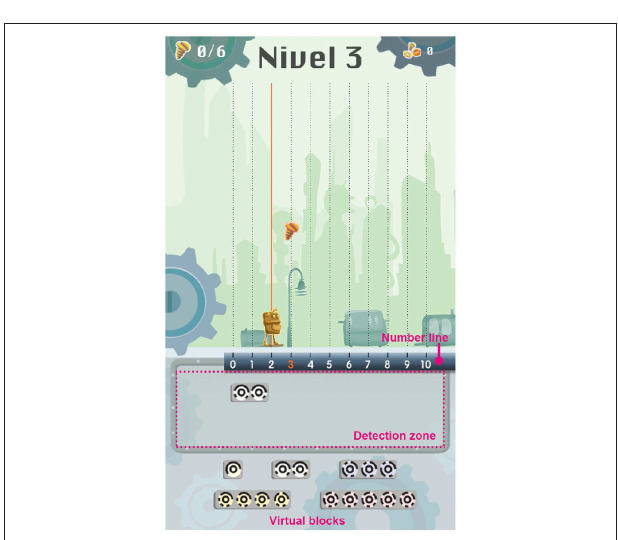
FIGURE 2 | Fully virtual version of BrUNO. Prize placed in number three (as indicated by the orange color). The player has already introduced 1 block of value 2. To reach the prize, he must add one block of value 1. In this example, a horizontal number line is present to help children locating numbers and to help in adding and subtracting